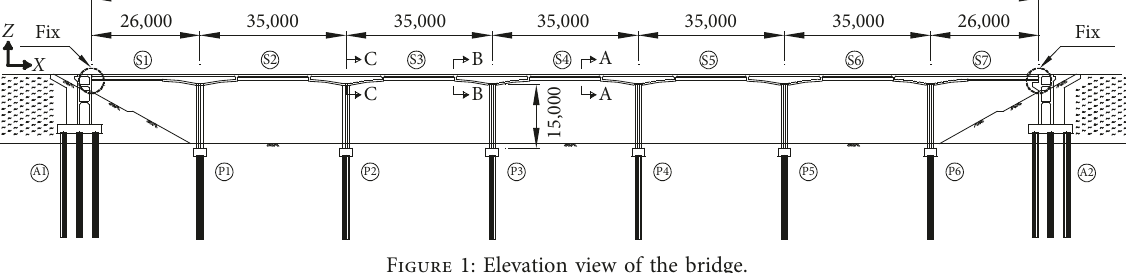
Figure 1: Elevation view of the bridge.